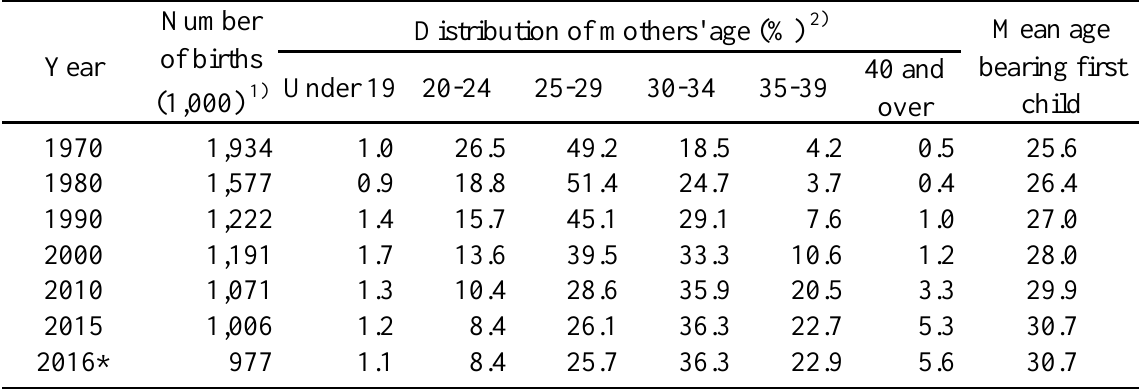
Table 2.7 Changes of Mothers' Age at Childbirth